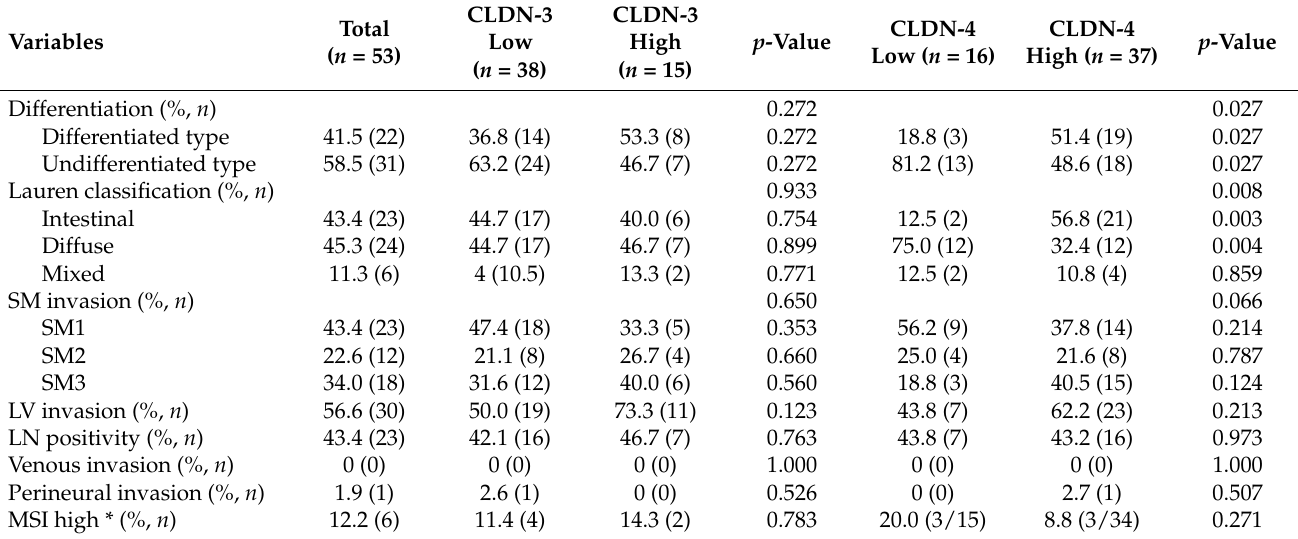
Table 2. Histopathologic features according to high and low expressions of CLDN-3 and